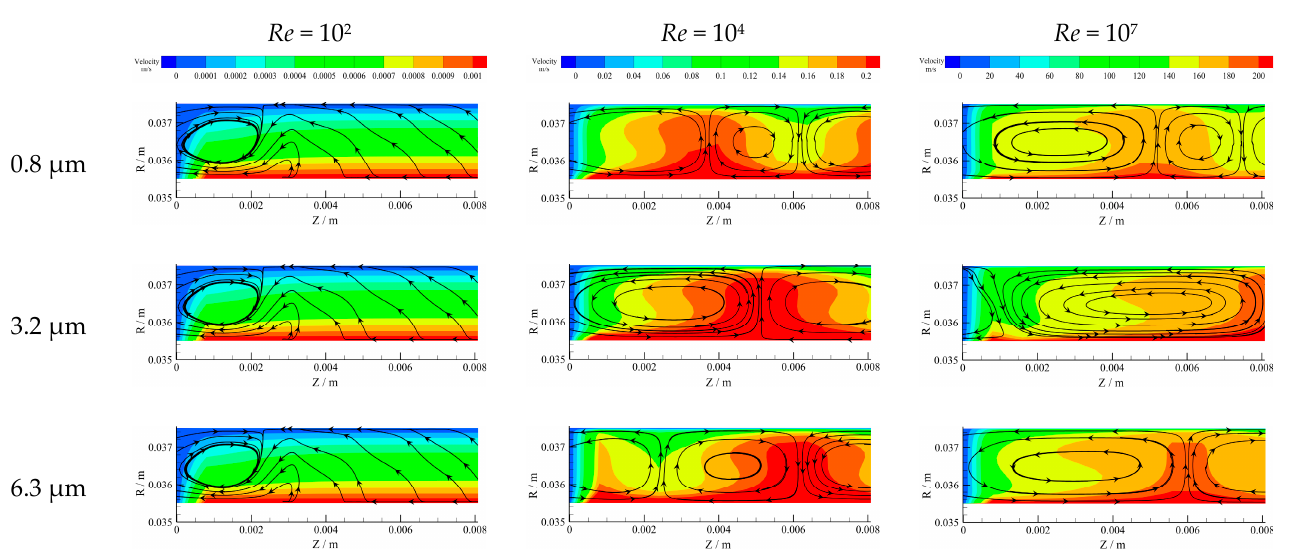
Figure 9. Streamlines and velocity magnitude at meridional plane with Re of 10 2 , 10 4 , and 10 7 for Ra = 0.8~6.3 μ m.